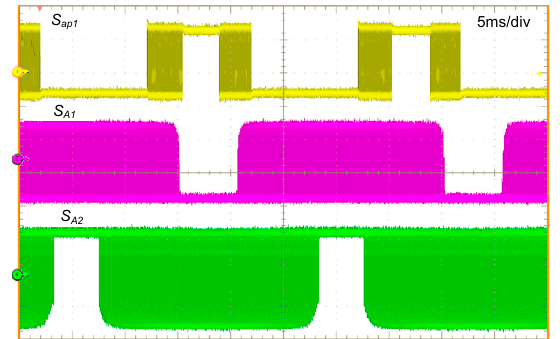
Figure 14. The PWM signals of rectifier and inverter stages.